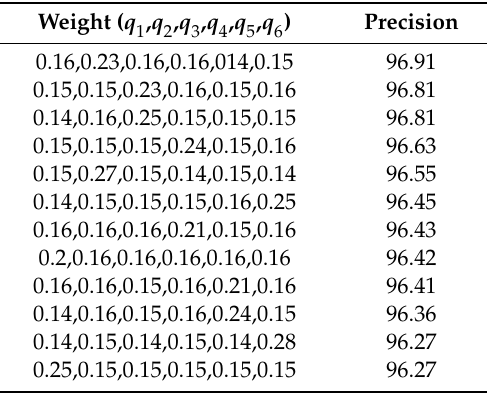
Table 4. Partial weight setting